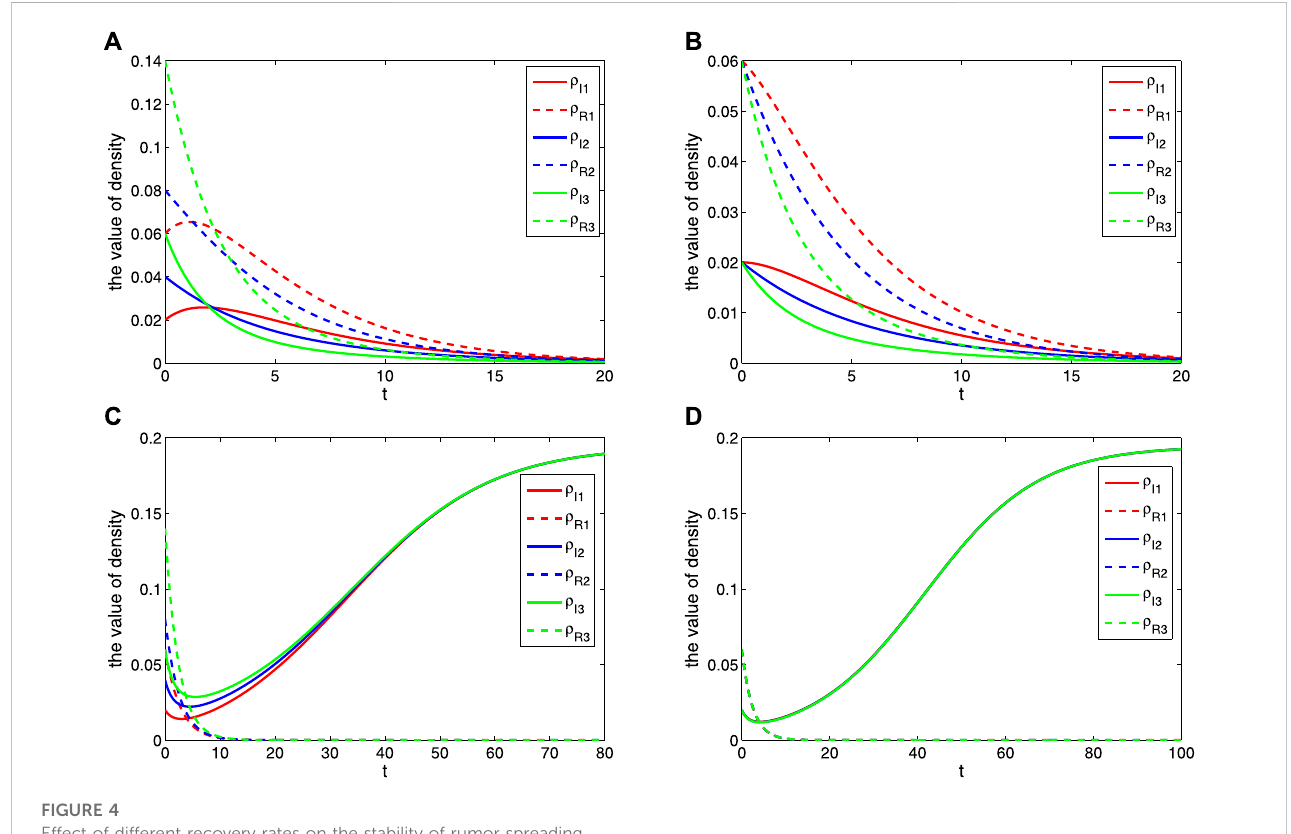
FIGURE 4 Effect of different recovery rates on the stability of rumor